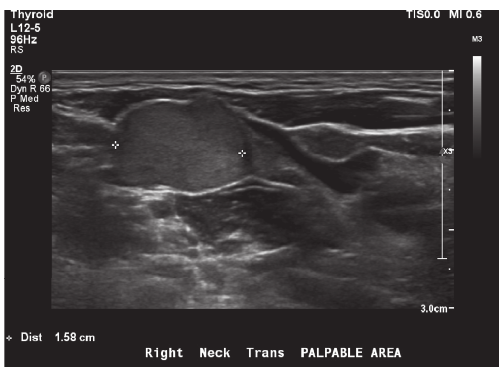
Figure 1: Ultrasound transverse image of the right palpable swelling showing abnormal cervical lymph node with localized invasion.